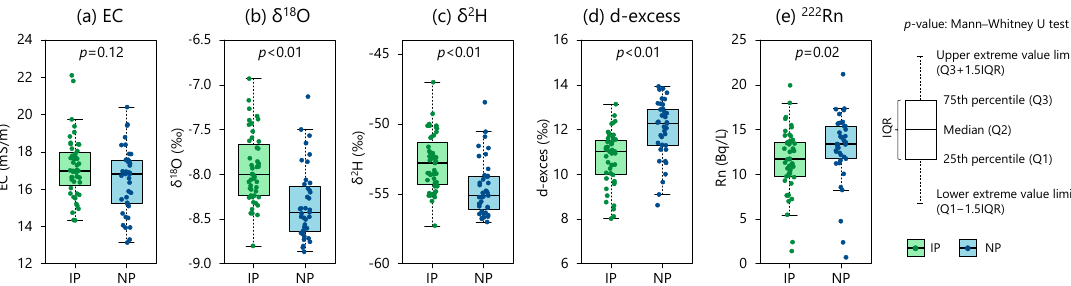
Figure 16. Comparison of groundwater EC values and isotopic compositions between the IP and NP at observation sites classified into group 2 in the IP.